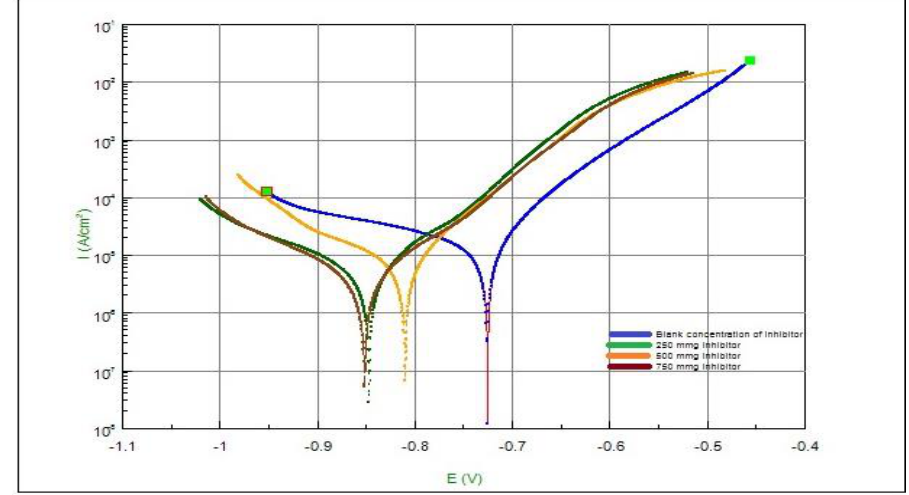
Fig. 4. Variation of inhibitor concentration on current density and voltage at 35oC